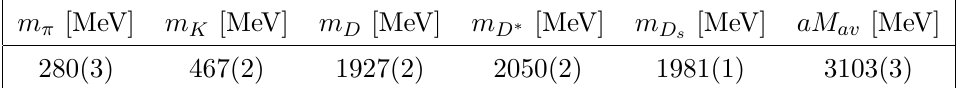
× N 3 = 128 × 24 3 and 96 × 32 3 T L